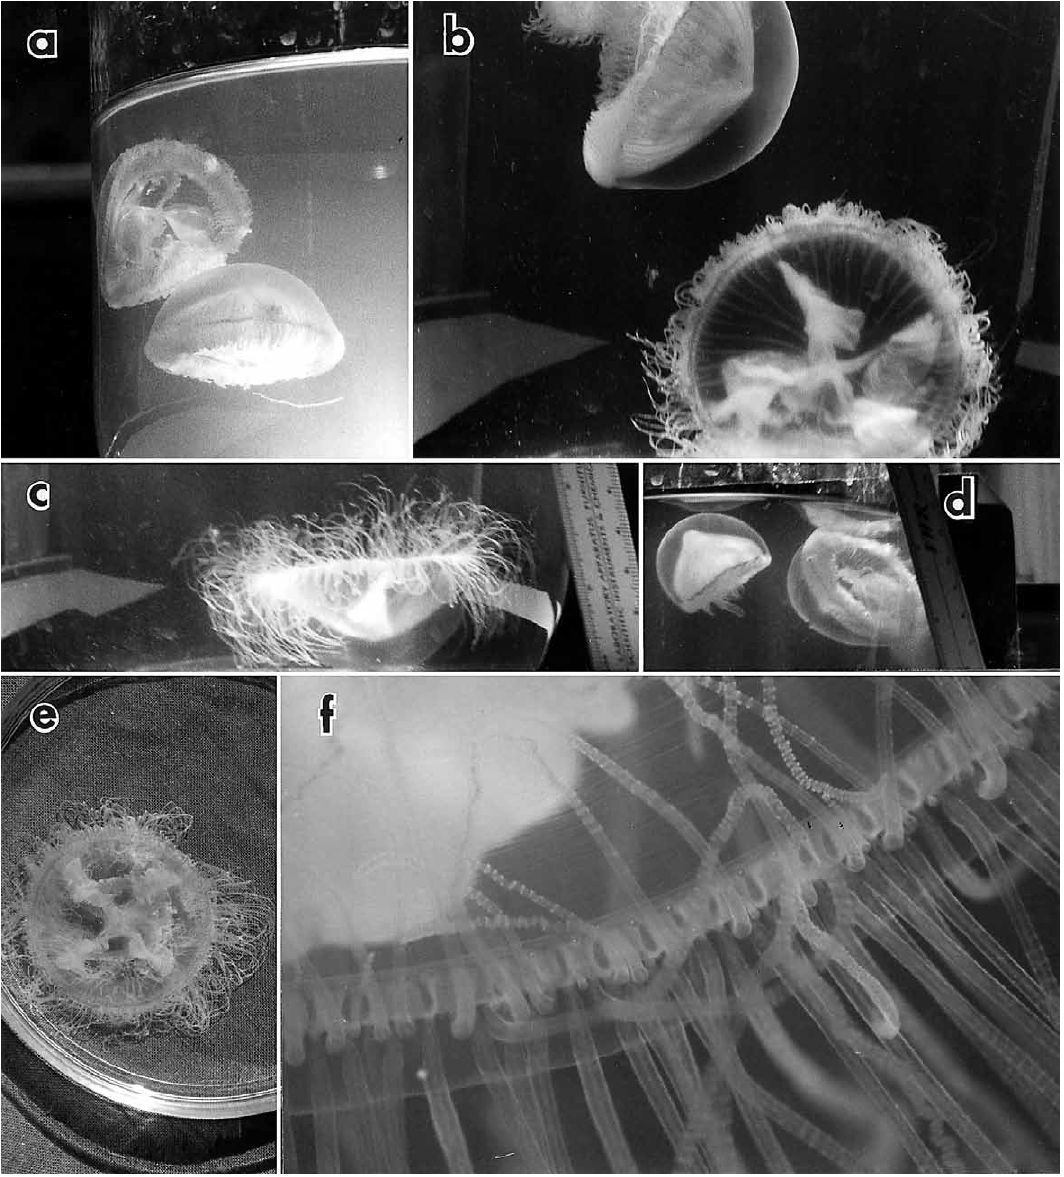
on the bottom. (d) Medusa at left shows maximum contraction of the bell while swimming. (e) Oral view of typical resting position on bot- tom. (f) Magnification of bell rim showing tentacles with rings of nematocysts, oval-shaped pigmented areas at bases of tentacles, and statocysts between the tentacle